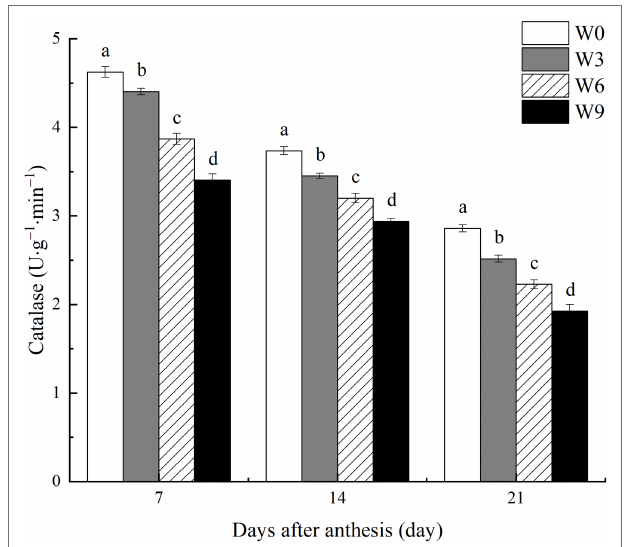
FIGURE 7 | Thousand-grain weight under different waterlogging durations. Data were collected at 7, 14, 21, and 28 days after anthesis. W0 = control, W3 = 3 days of waterlogging, W6 = 6 days of waterlogging, W9 = 9 days of waterlogging. The values are the mean of each treatment (six replicates across two years) ± SE (standard errors). Means carrying the same letter are not significantly different at the 5%